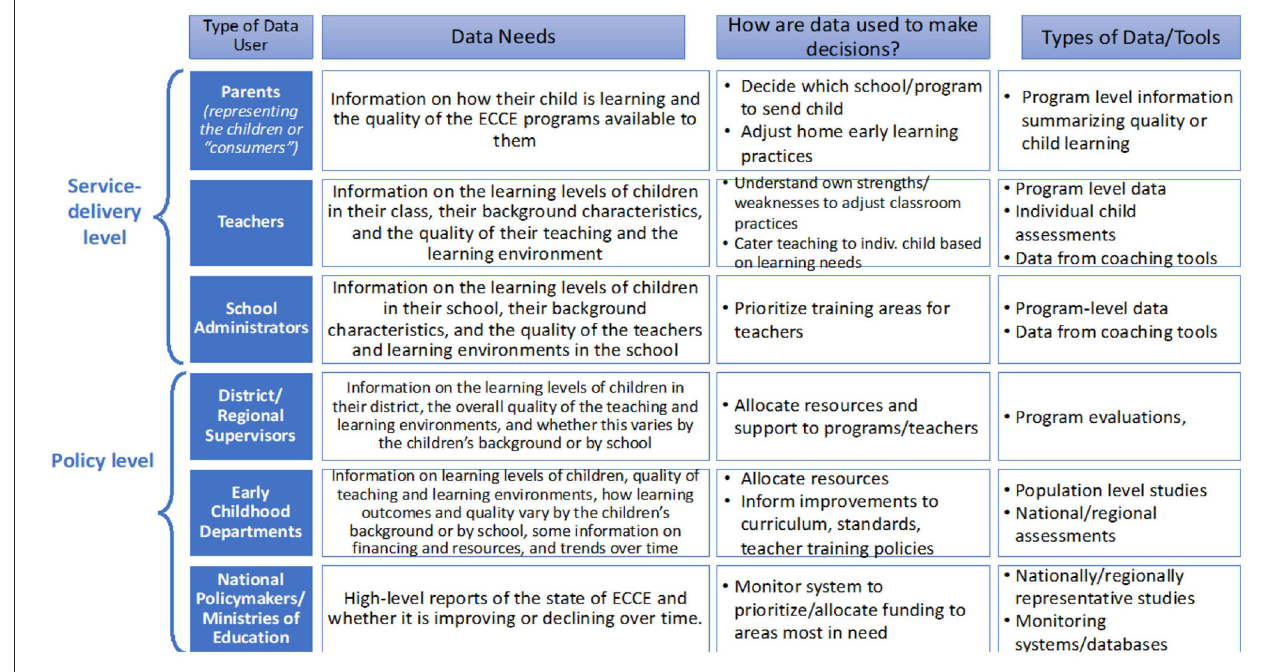
FIGURE 2 | ECE data users and data